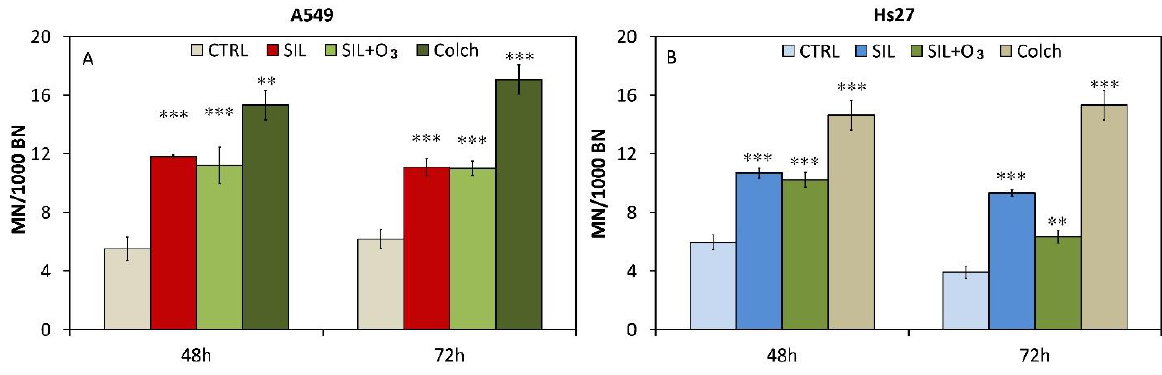
Figure 4. Micronuclei refers to 1000 binucleated cells (MN/1000 BN) in cell lines A549 ( A ) and HS27 ( B) : control, silica, and silica/ozone. Colchicine (0.1 μ g/mL) was used as positive control. Significance values were determined according to the Student t -test: ** = p < 0.005; *** = p < 0.0005. All treated were compared to their respective controls. Error bars are the standard error of the mean.